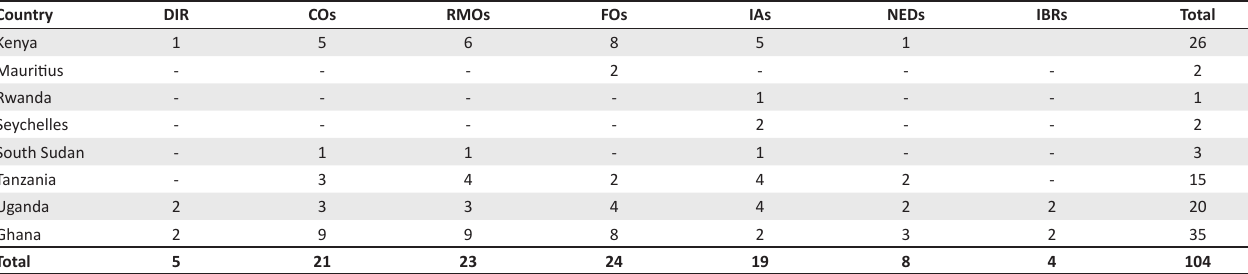
TABLE 1: Number of participants from East and West African countries.